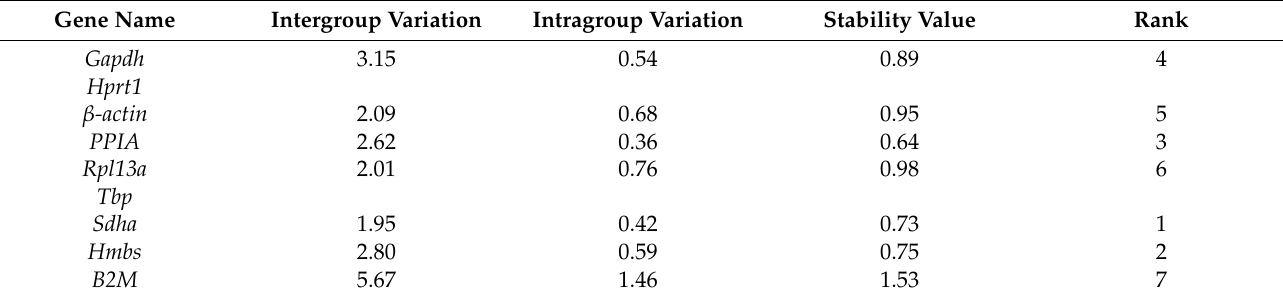
Table 4. Expression features in different tissues at PND 4W under the natural photoperiod condition analyzed by